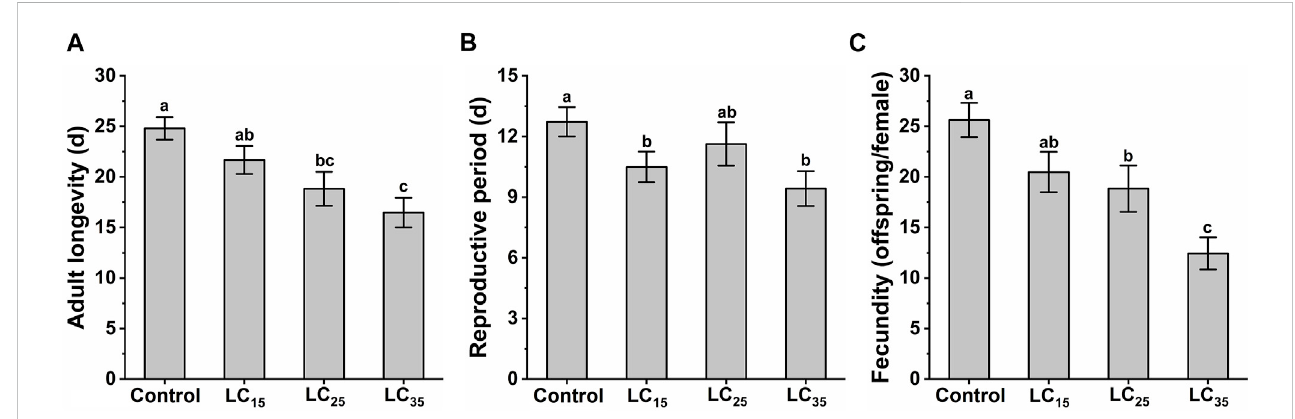
FIGURE 1 The adult longevity (A) , reproductive period (B) and fecundity (C) of Metopolophium dirhodum F 0 generation under control conditions, treated with 50 mg/L of imidacloprid (LC 15 ), 100 mg/L of imidacloprid (LC 25 ) and 200 mg/L of imidacloprid (LC 35 ).